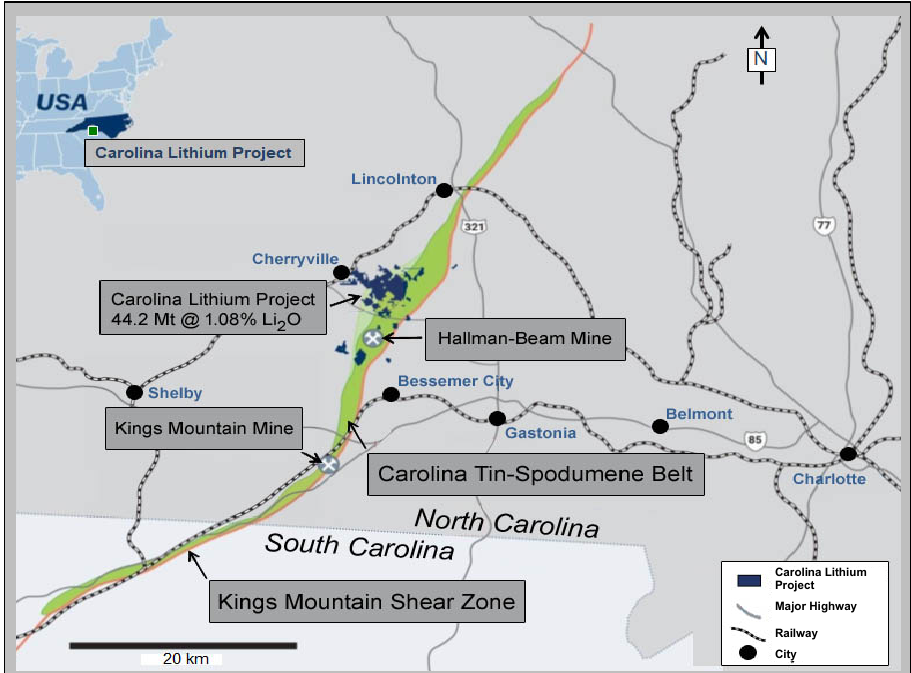
Figure 1. Carolina Tin-Spodumene Belt (green) showing the Kings Mountain Shear Zone (orange), the Kings Mountain and Hallman-Beam Li mines, and Piedmont Lithium’s Carolina Lithium Project (CLP) prospect in Gaston County, N.C. that has an estimated reserve of 44.2 Mt at 1.08 wt. % Li 2 O (modified from map provided by Piedmont Lithium Inc. on 29 October 2021).